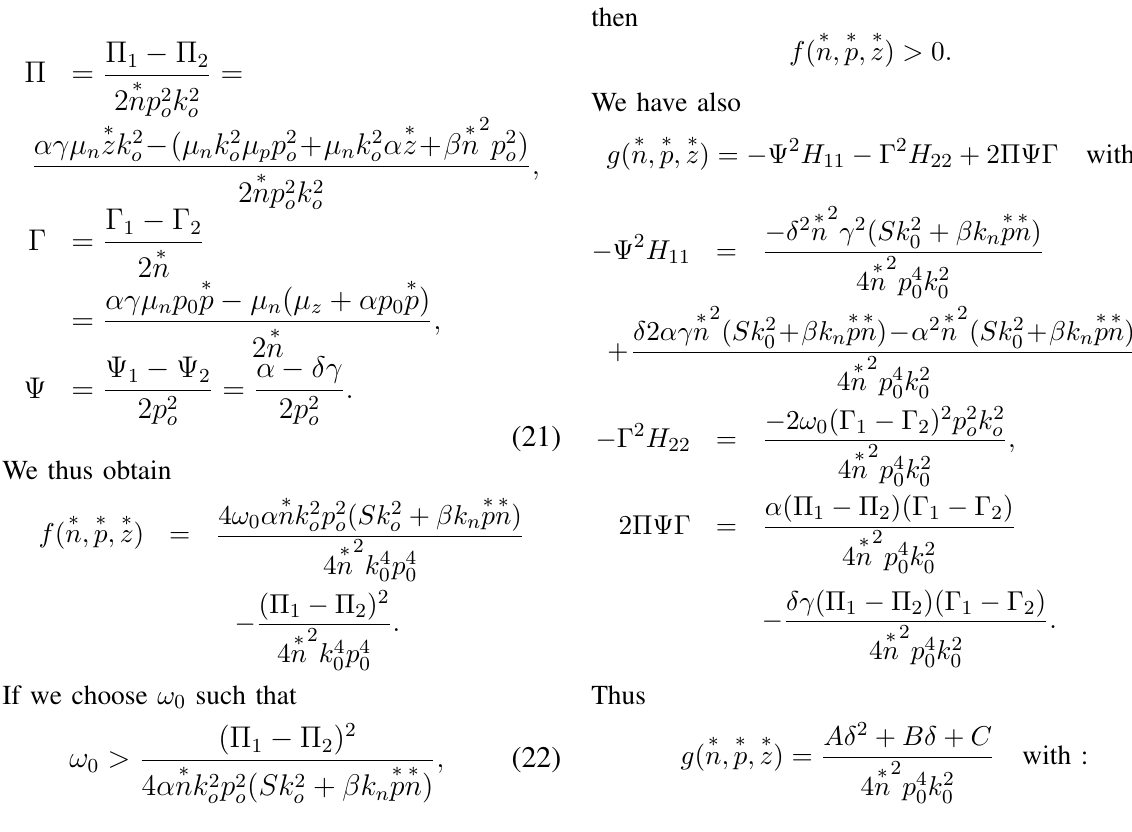
Fig. 1: (i)- Some orbits in the phase space. The point in black is the equilibrium e parameters (blue), coordinates of e 3 (black) and associated eigenvalues (red). (iii)- Density evolution vs time transient phase and (iv) permanent phase. ω 0 = 1 . 79 et ∆ = 0 .